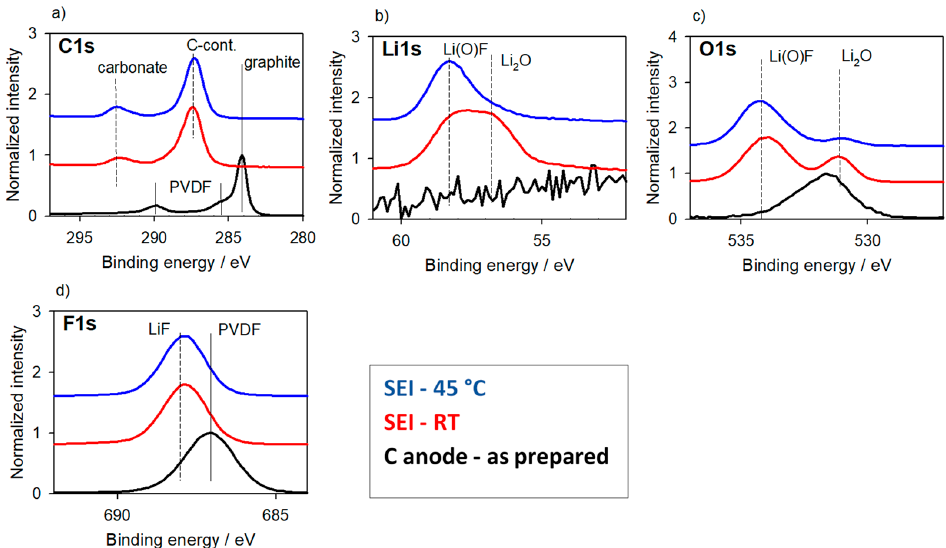
Figure 4. XP spectra normalized in intensity of graphite-based anode material; as prepared, with SEI formed during charging (lithiation) at room temperature and 45 °C ( bottom to top ). Here, no charging was observed and no BE correction was necessary. After charging (lithiation) all characteristic peaks are shifted around 2–3 eV with respect to the standard C1s (284.8 eV) BE calibration. At higher temperature a higher amount of Li-fluoride is observed. ( a ) C1s; ( b ) Li1s; ( c ) O1s; ( d ) F1s transition.